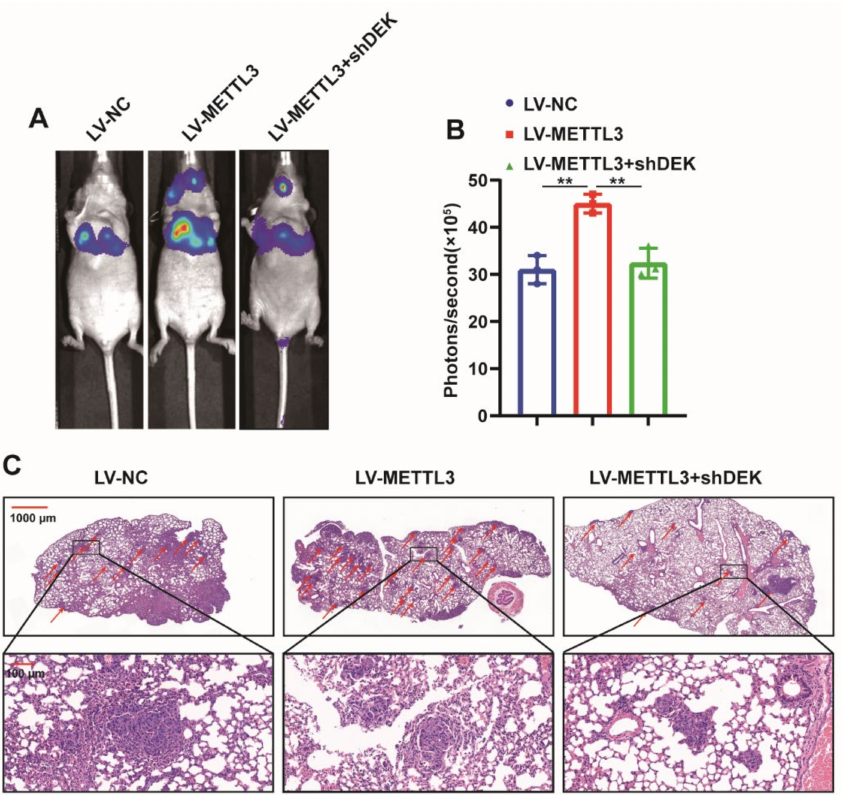
Figure 6. METTL3 promotes GC metastasis in vivo. ( A ) LV-NC, LV-METTL3 and LV-METTL3+shDEK cells were injected into nude mice via tail vein, and the growth of lung metastases was monitored by bioluminescence imaging 28 days later ( n = 3). ( B ) Statistical analysis of luminescence values of nude mice bioluminescence imaging to monitor lung metastases (**: p < 0.01). ( C ) Representative image of nude mouse lung tissue for HE staining to evaluate lung